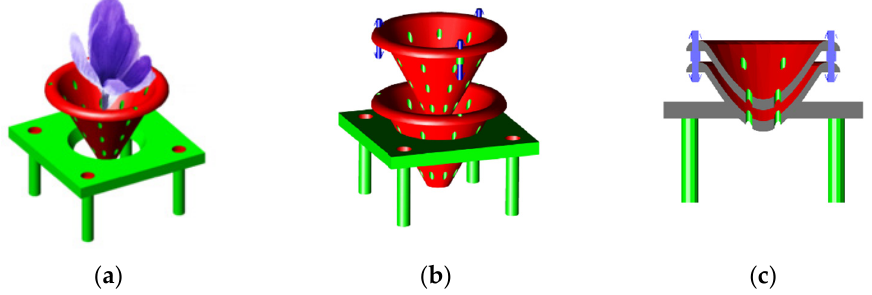
Figure 5. First element of the funnel-shaped device with relative support base ( a ); two funnel-shaped elements in the phase of their coupling ( b ); longitudinal section of two funnel-shaped coupled containers ( c ).